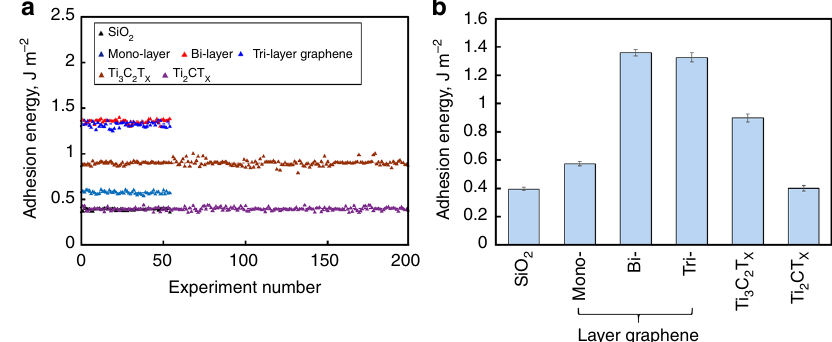
Fig. 5 a Adhesion energy for all measured samples (since adhesion energy of Ti 3 C 2 T x and Ti 2 CT x thin fi lms is independent of the fi lm thickness, MXene fi lms with different number of monolayers are represented by one symbol in the graph), b average adhesion energies with error bars indicating standard